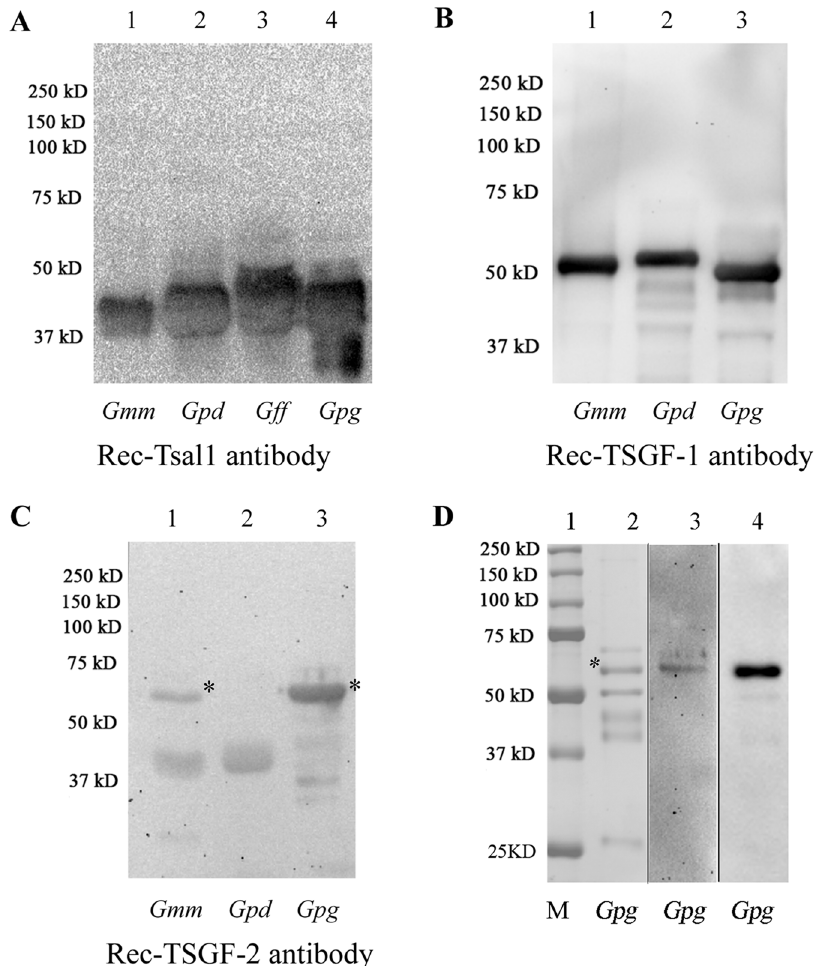
Fig 4. Immunoblot of sialome proteins from Gmm , Gpd , Gff and Gpg . Same amount of sialome proteins from Gmm , Gpd , Gff and Gpg were probed with (A) rec- Gmm Tsal1, (B) rec- Gmm TSGF-1 and (C) rec- Gmm TSGF-2 antibodies, respectively. (D) Gpg sialome components, equivalent to 0.2 pairs of salivary glands, are analyzed on Coomassie Blue stained SDS-PAGE (lane 2), and by immunoblot analysis using rec- Gmm TSGF-2 antibodies (lane 3) and anti- Gff saliva antibodies (lane 4). Lane 1 shows molecular marker. * indicates TSGF-2 corresponding protein